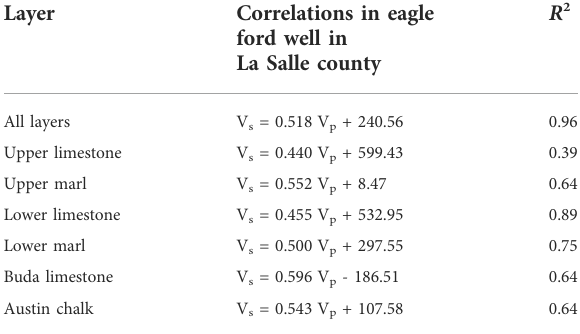
TABLE 4 Correlations of compressional and shear velocities of Eagle Ford well in La Salle County (in m/s). Layer Correlations in eagle ford well in